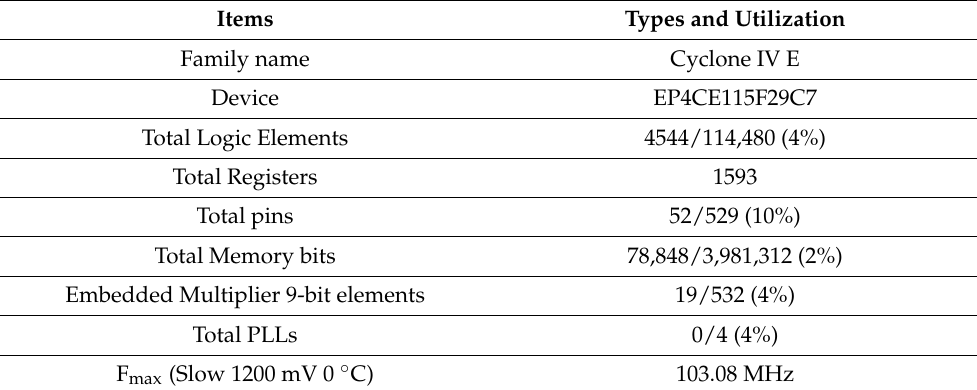
Table 5. Synthesis summary report of the digital Fuzzy Feedback Controller (FFC) using the Intel field-programmable gate array (FPGA) (Cyclone IV E)